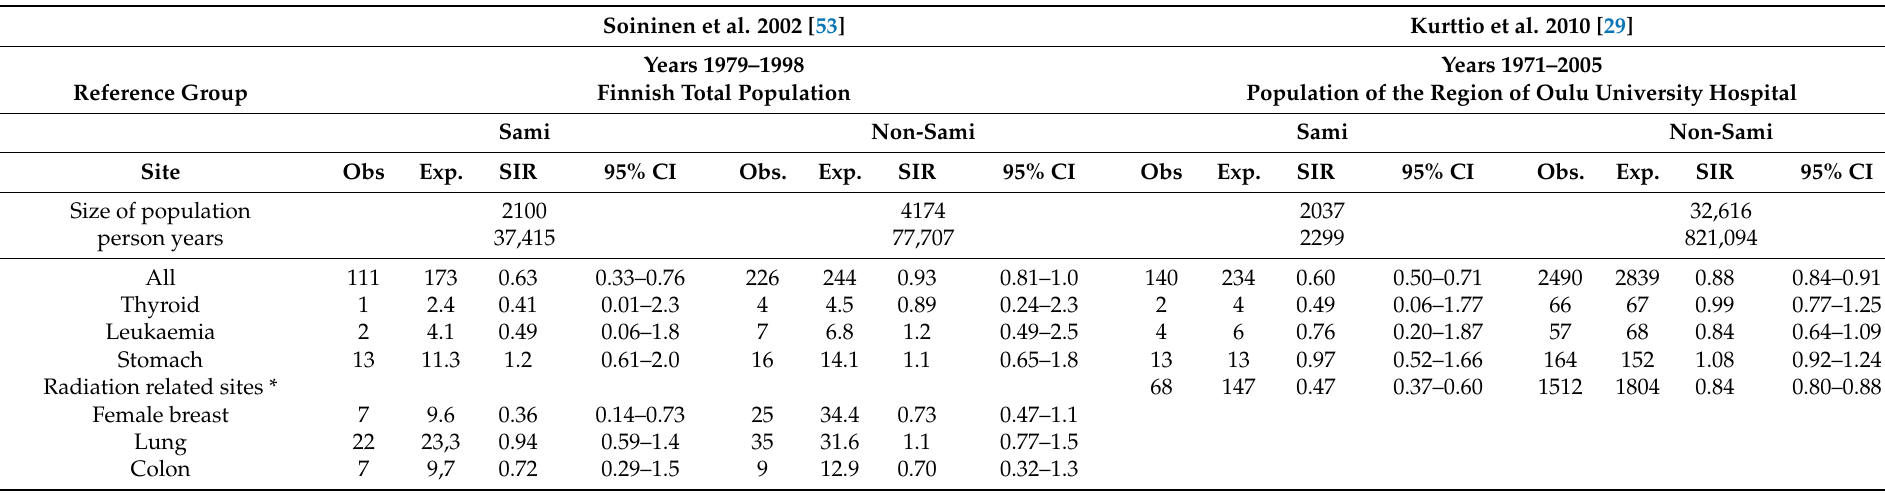
Table 4. Observed (Obs.) and expected (Exp.) number of cancer cases and standardized Incidence ratios (SIR) with 95% confidence intervals (CI) among Sami and Non-Sami